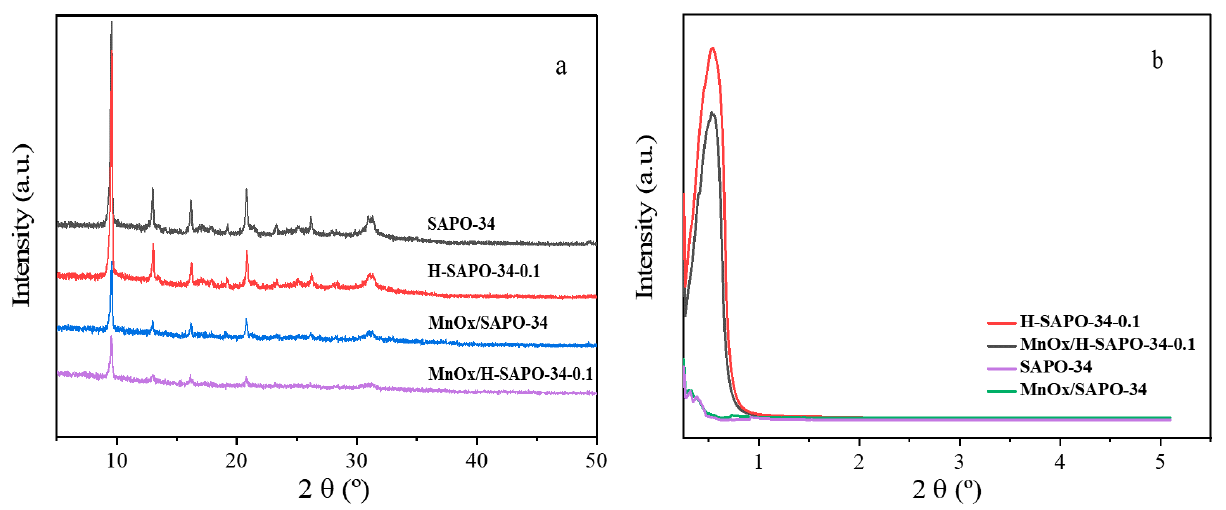
Figure 1. XRD patterns of SAPO-34, H-SAPO-34-0.1, ( a ) MnO x /SAPO-34 and ( b ) MnO x /H-SAPO-34-0.1 catalysts.